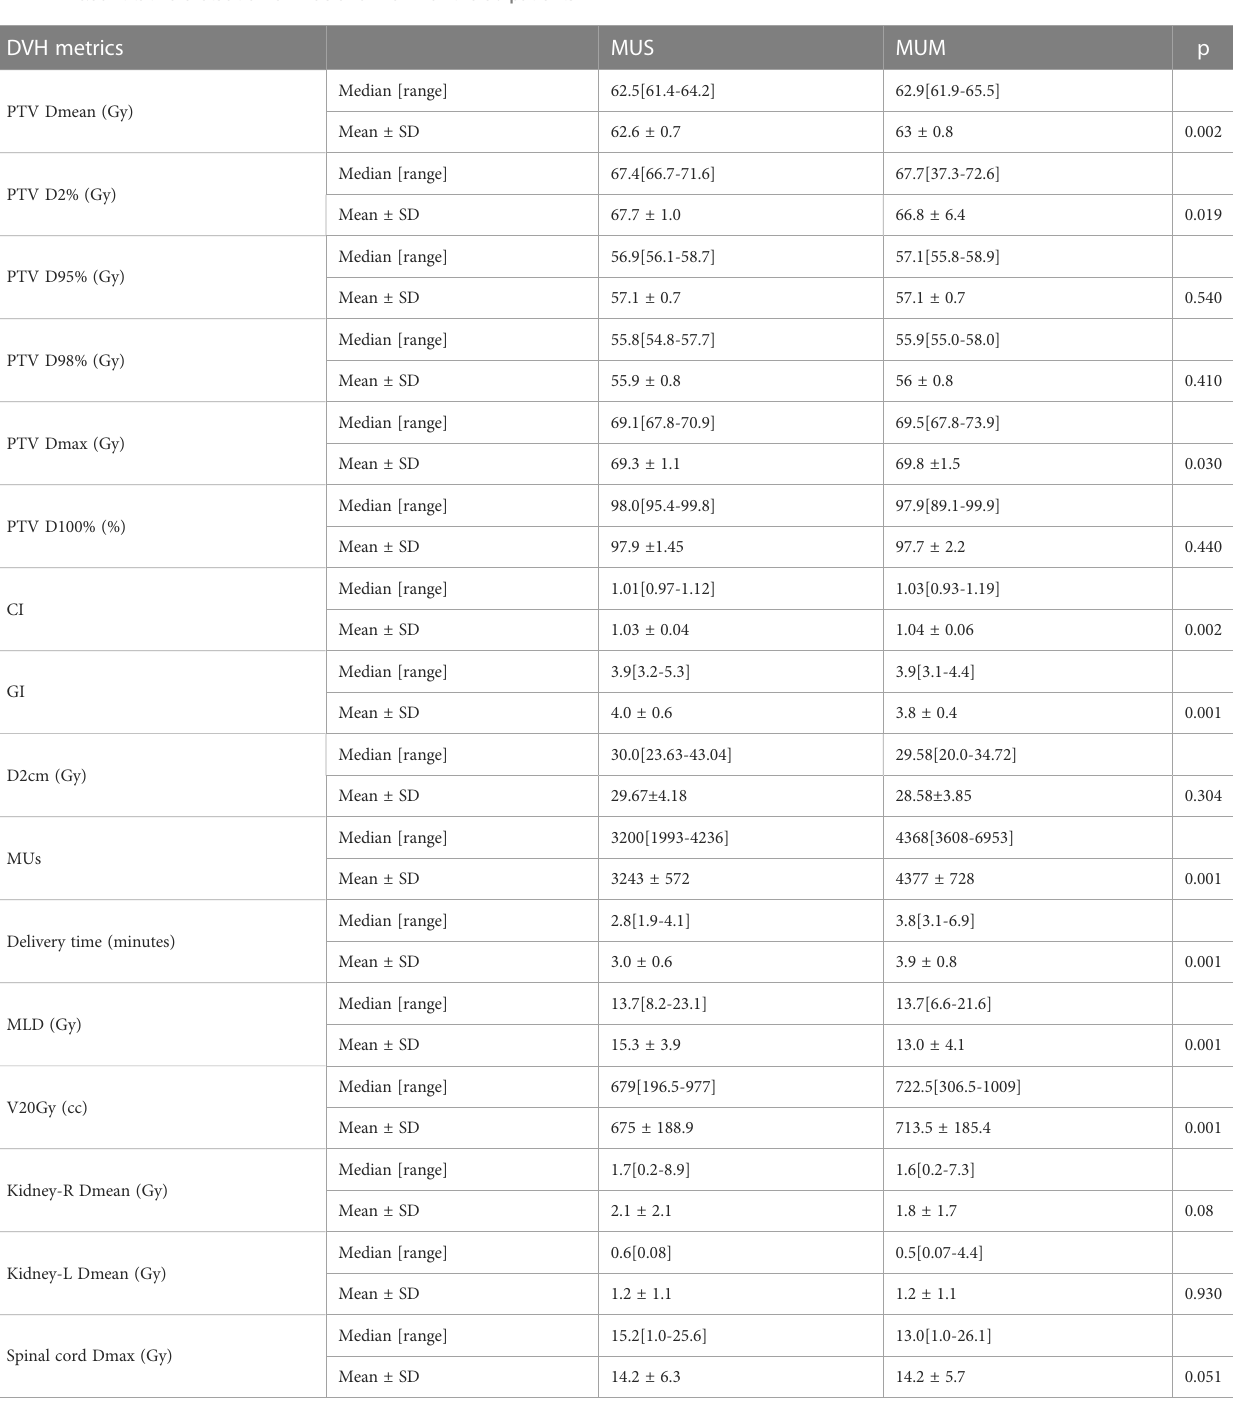
TABLE 2 Quantitative evaluation of MUS and MUM for the 30